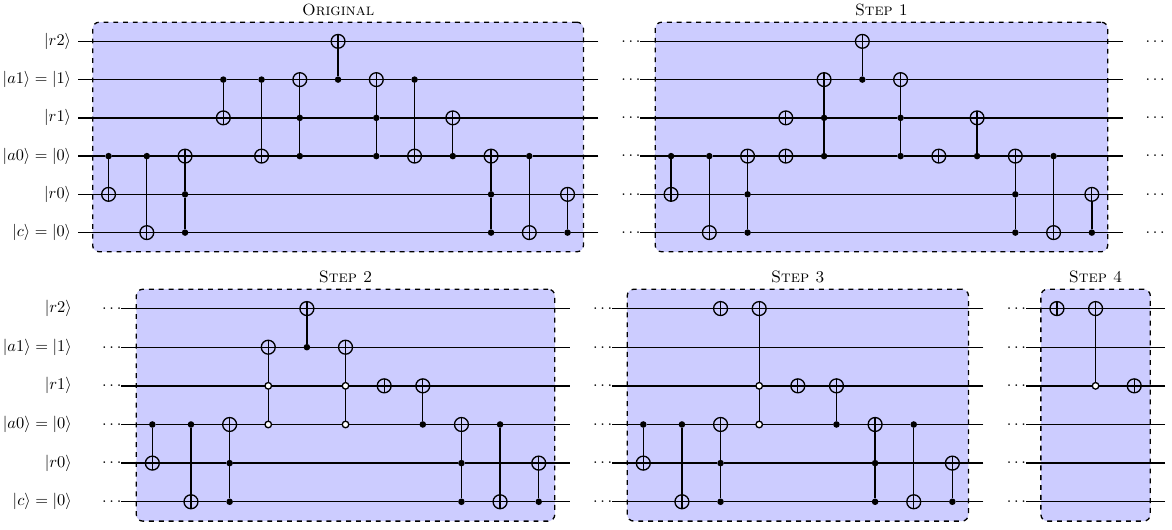
= a 1 a 0 10 | | (cid:105) | (cid:105)